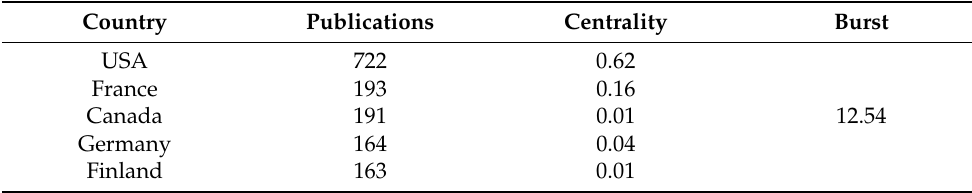
Table 3. Top 10 countries on the number of published